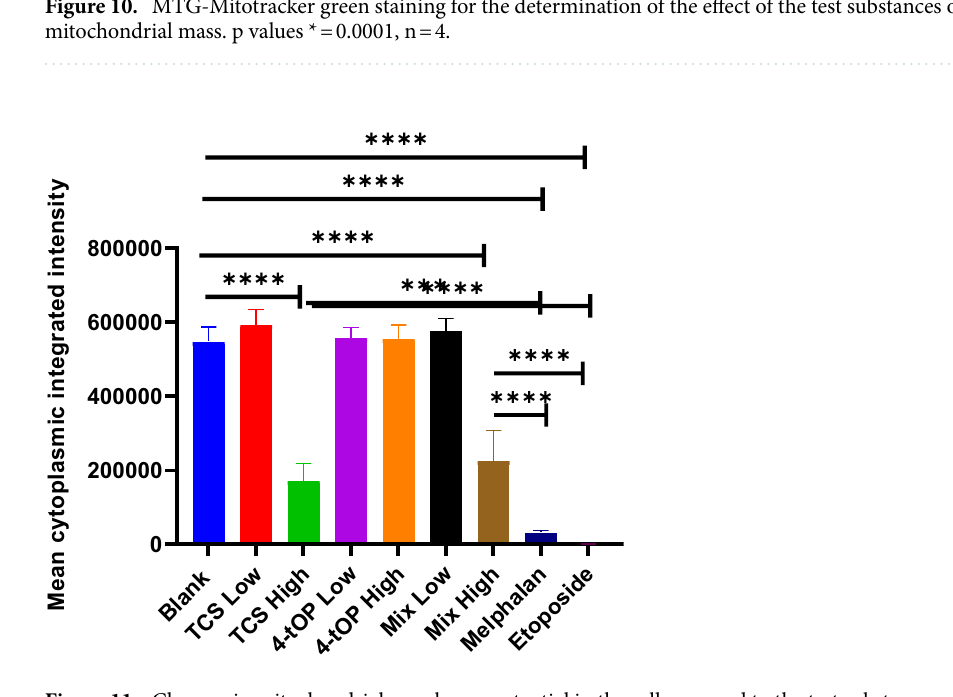
Figure 11. Changes in mitochondrial membrane potential in the cells exposed to the test substances. p values **** = 0.0001, Mel *** = 0.0009, Etop **** = 0.0001, n =